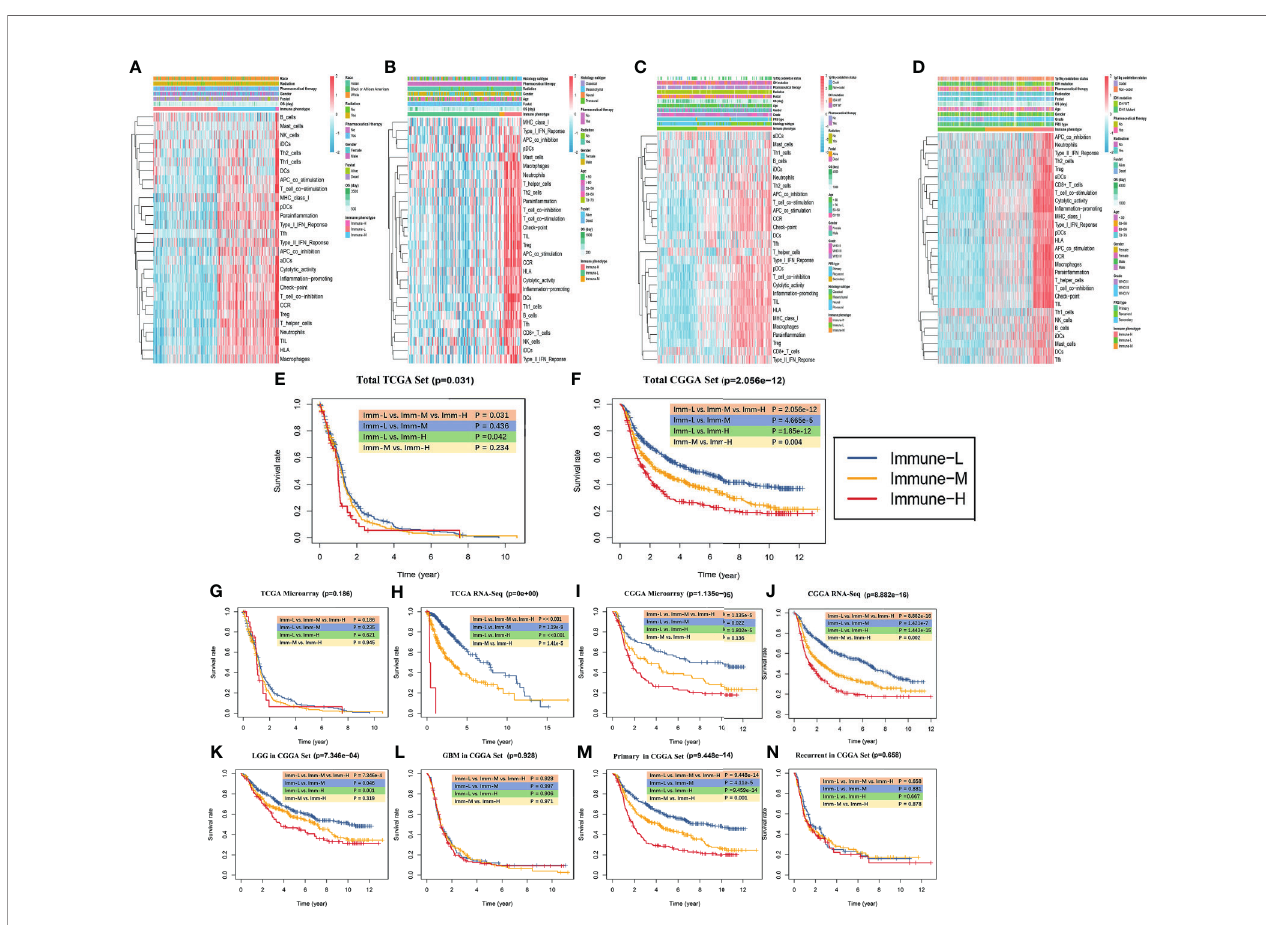
FIGURE 4 | Survival data showing that the immune-H phenotype is associated with a poor prognosis. (A – D) Complex heatmaps including ssGSEA results and clinical information from involved TCGA microarray, TCGA GBM RNA-seq, CGGA microarray, and CGGA RNA-seq cohorts. (E, F) Survival plots showed immune-H phenotype had poorer survival in all three immune phenotypes in total TCGA (P = 0.031) and CGGA (P = 2.056e-12) datasets. (G – J) Survival plots showing prognosis discrepancies among three immune phenotypes in TCGA microarray, TCGA RNA-Seq, CGGA microarray, CGGA RNA-Seq cohorts. (K – N) Survival plots for the LGG, GBM, primary glioma and recurrent glioma subpopulations in the total CGGA dataset. The log-rank test P value among three phenotypes and every two phenotypes are marked and